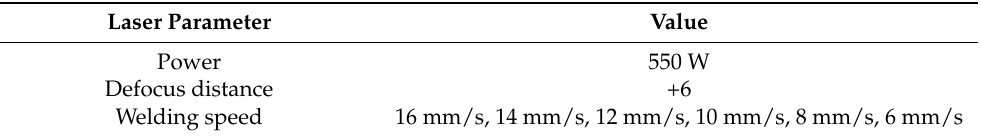
Table 2. Laser welding process